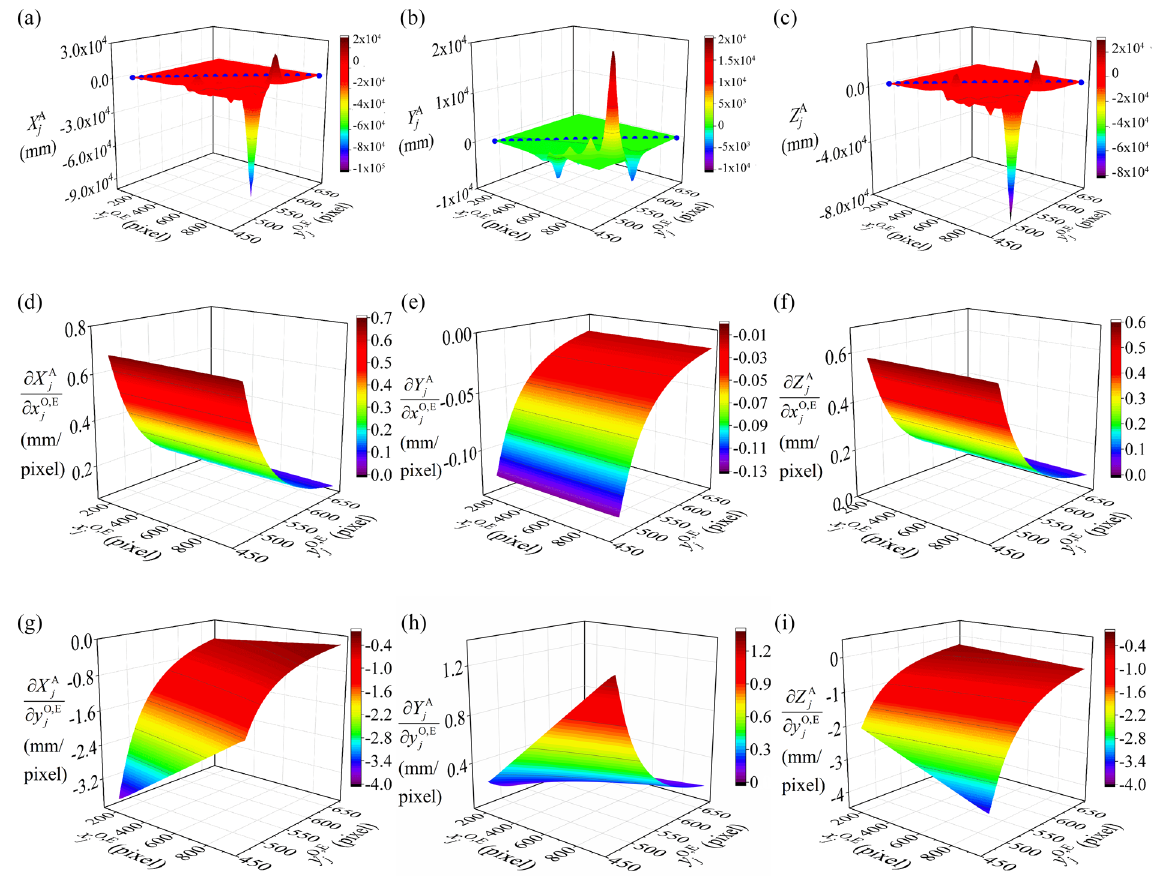
Figure 8. Verification experiments and simulation results of the coordinates of the image point. ( a – c ) the relationship between the coordinates X A j , Y A j , Z A j and the image coordinates x between the partial derivatives ∂ X A j /∂ x the relationship between the partial derivatives ∂ X A j /∂ x x O,E y O,E j , j